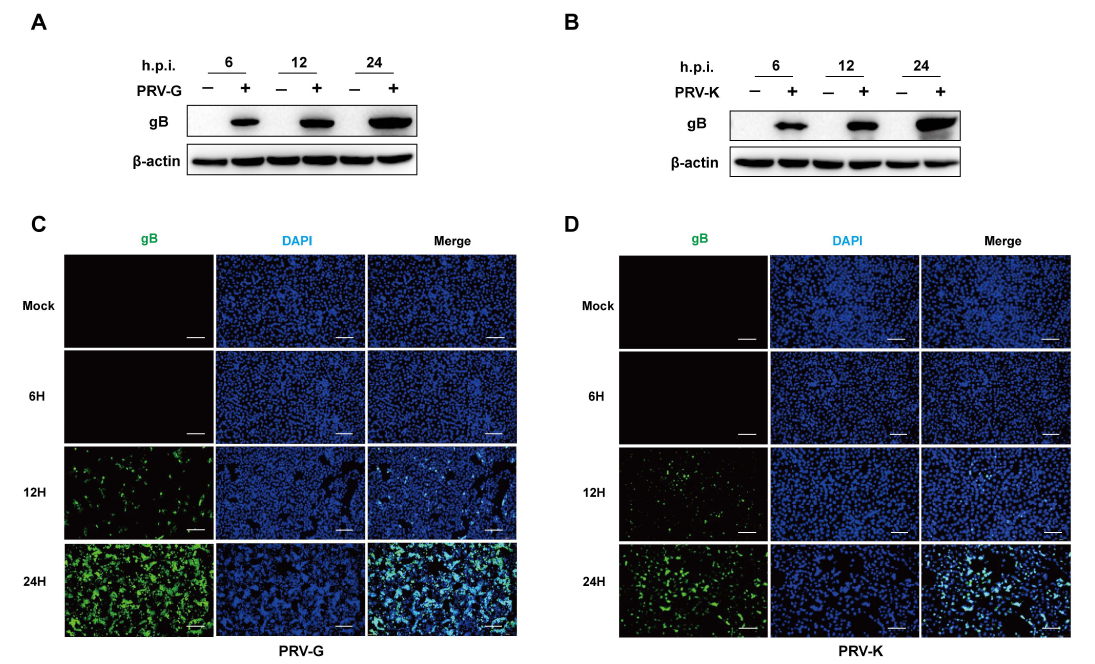
Figure 1. Infections of different PRV strains in PK-15 cells. ( A , B ) The cells were infected with PRV variant strain (abbreviation of PRV-G) and PRV Bartha K61 strain (abbreviation of PRV-K) at MOI = 1, and cell samples were collected at 6, 12, and 24 h for immunoblotting detection. ( C , D ) PK-15 cells were infected with PRV-G and PRV-K at MOI = 1 for 6, 12, and 24 h at 37 ◦ C with 5% CO 2 . The expression levels of PRV-gB protein detected by IFA. Scale bars = 200 µ m.